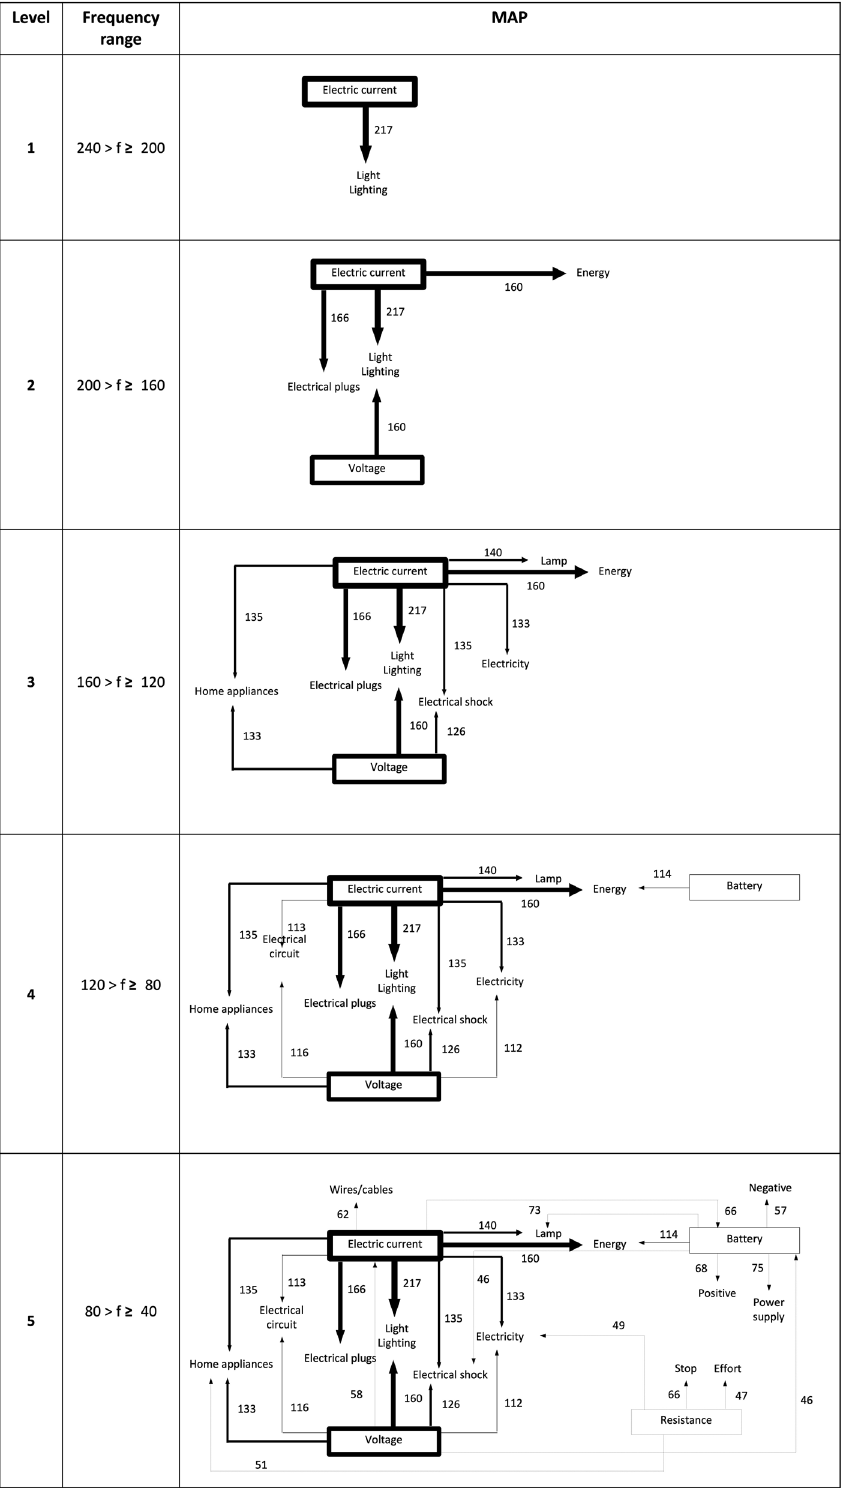
Fig. 3 Map of students’ cognitive structures at M2 (control